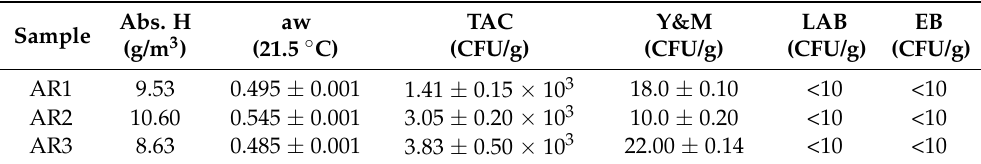
Table 2. Plant material characterization: absolute humidity (Abs. H); active water at 21.5 ◦ C (aw); total aerobic count (TAC); yeast and molds (Y&M); lactic acid bacteria (LAB); Enterobacteriaceae (EB); CFU: colony-forming